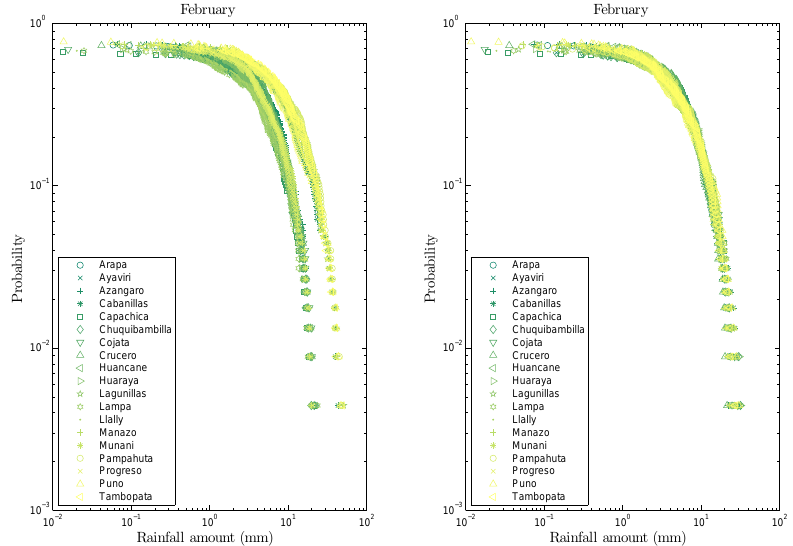
Figure 15. Exceedance probability plots for February over an 8-year period of (right) TRMM data ( R rainfall field) and (left) TRMM with long-term averages (monthly) removed ( M rainfall field).